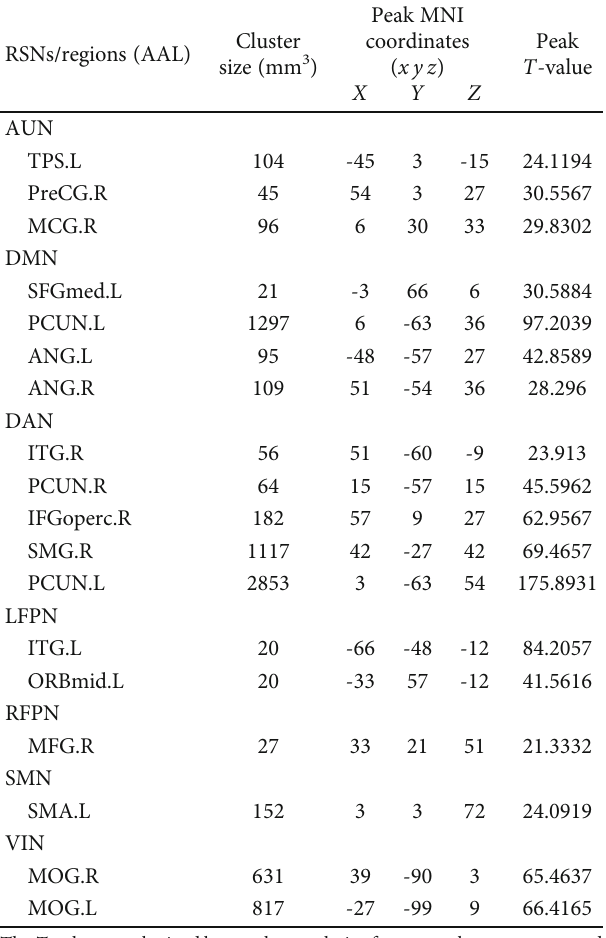
Table 2: Brain regions in resting-state networks (RSNs) with signi fi cant di ff erences in functional connectivity among FOG+, FOG-, and HC